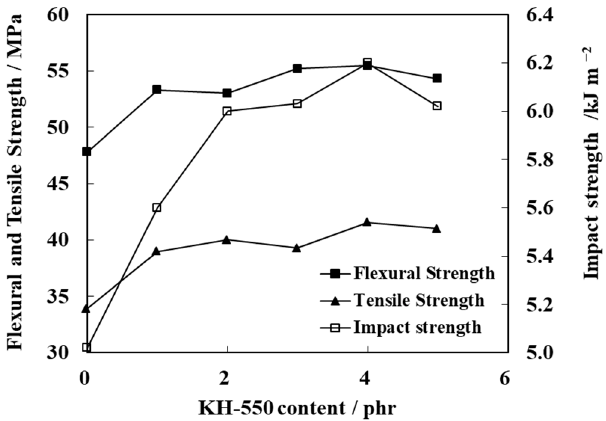
Figure 6. Effect of the KH-550 content on the mechanical properties of PP/N-WPCB composites.